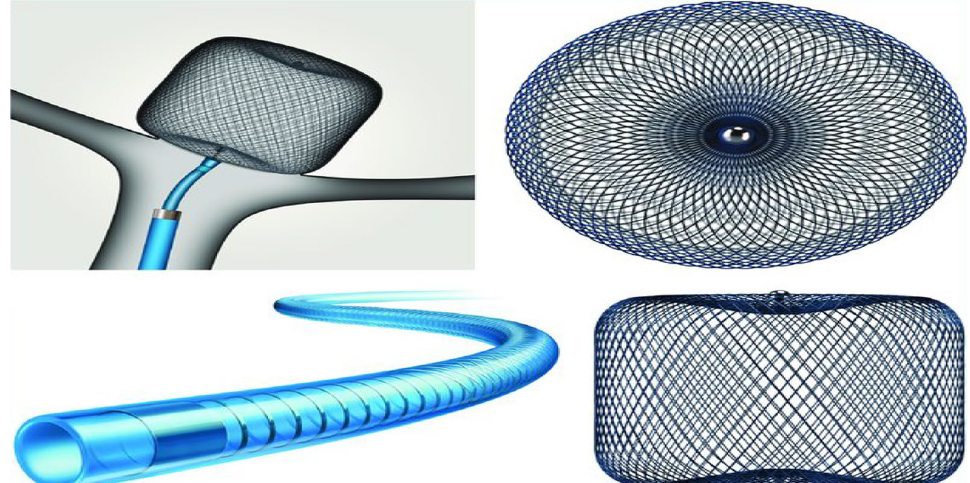
Fig. 2 Illustration for Woven EndoBridge (WEB; Microvention) device (This figure was uploaded by Adam A Dmytriw Content may be subject